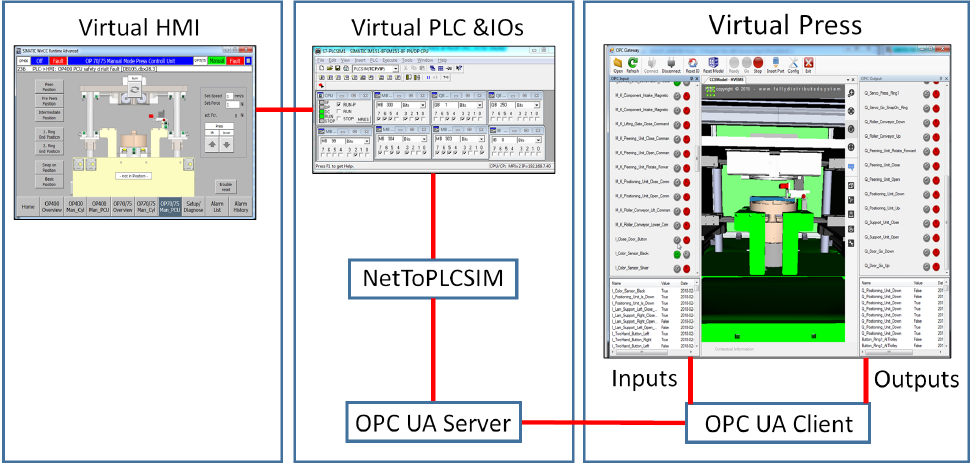
Figure 8. Vertical assembly station VC architecture